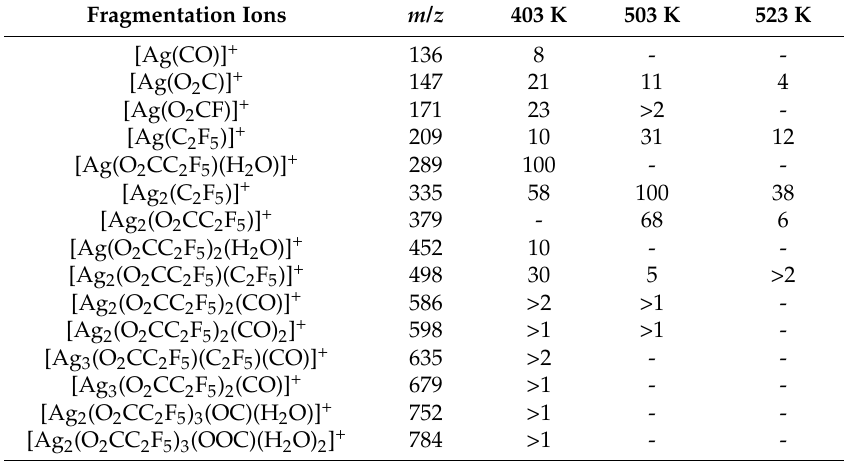
Table 2. Silver(I) fragmentation ions present on the mass spectra (MS EI) of [Ag 5 (O 2 CC 2 F 5 ) 5 (H 2 O) 3 ] registered at 403 and 513 K.